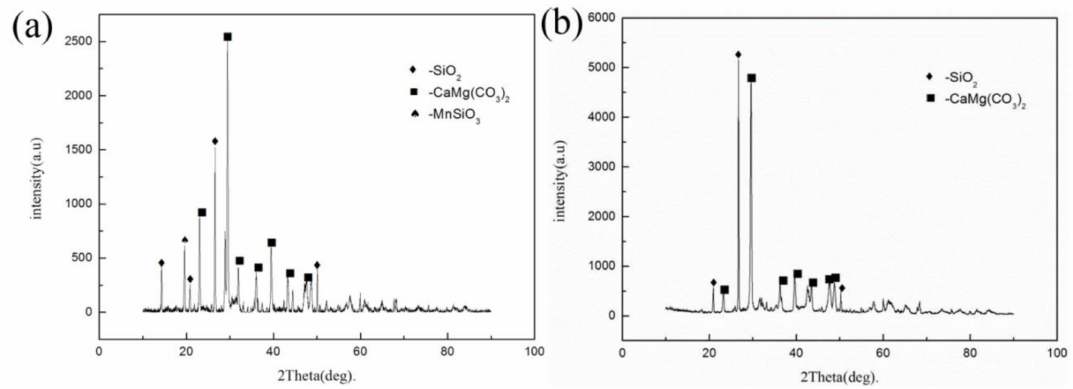
Figure 5. ( a ) Without ammonium fluoride in XRD diagram of slag leaching; ( b ) with ammonium fluoride in XRD diagram of slag leaching. Table 2. The ranges and levels of CCD variables in ammoniacal leaching of roasted manganese ore by ammonium fluoride. Investigate Factors